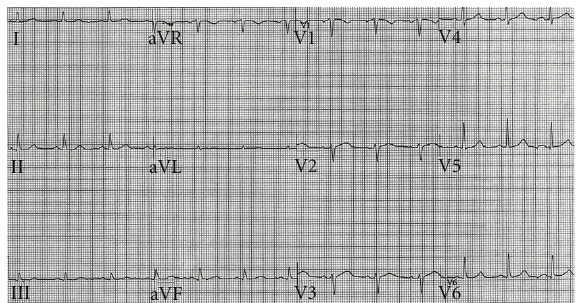
Figure 6: ECG six months later: normal sinus rhythm 73 bpm, QTc